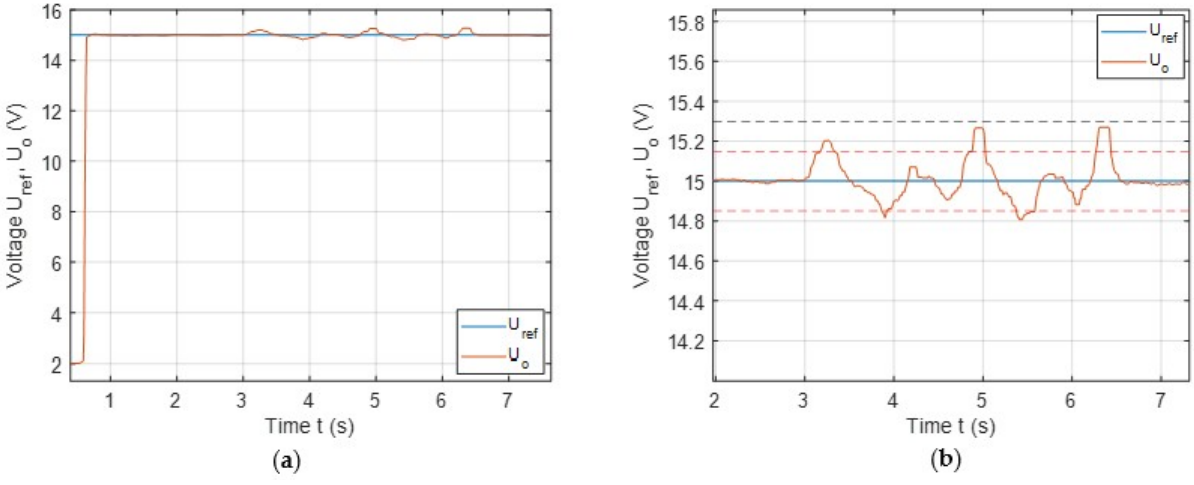
Figure 10. Influence of rotation α on the output voltage: ( a ) large scale; ( b ) small